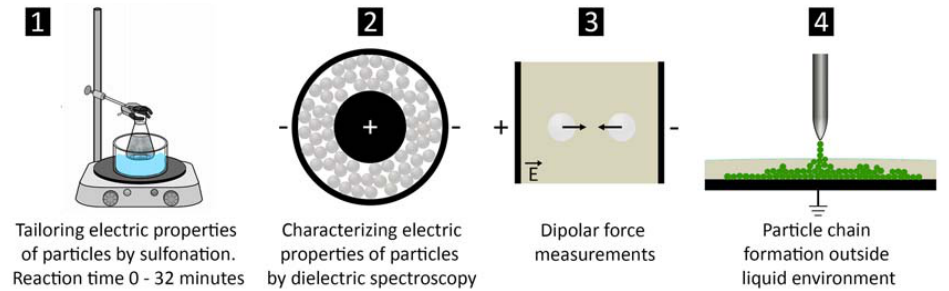
Figure 1. Scheme of the study. ( 1 ) The electric properties of polystyrene particles are tailored by sulfonating particles for different reaction times; ( 2,3 ) Differences in electric properties of the particles are characterized and verified by dielectric spectroscopy and dipolar force measurements; ( 4 ) Particle chaining from oil to air environments is investigated for pure and modified polystyrene particles.